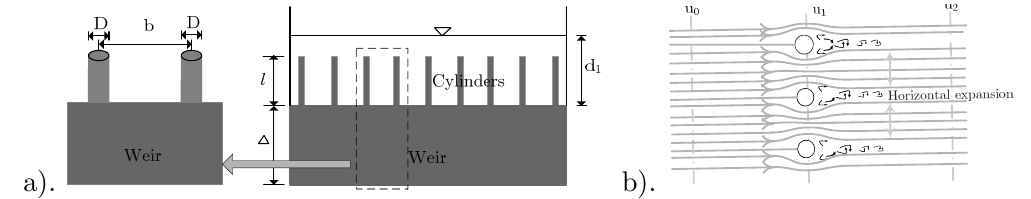
Fig. 5. (a) Cross section of weir with vegetation roughness at Sect. 1; (b) flow around the cylindrical rods on the weir crest (Top